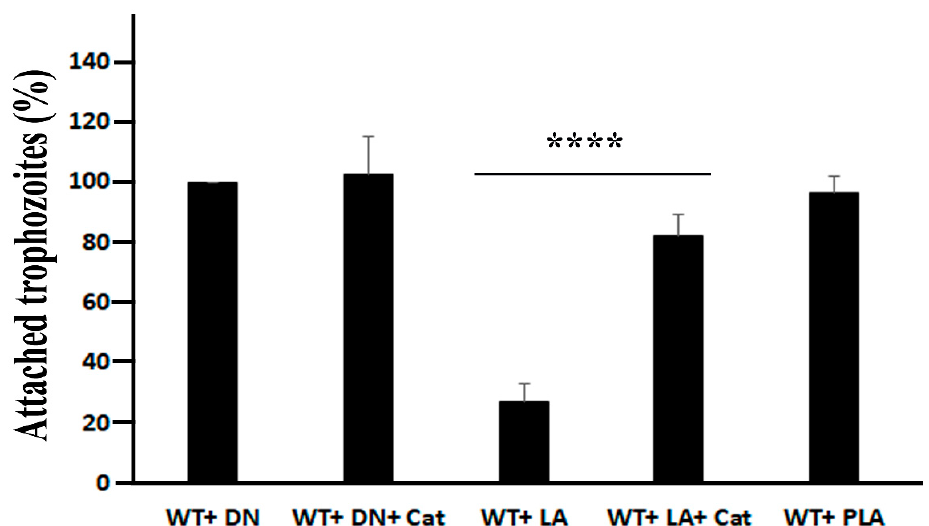
Figure 5. Binding activity assay of E. histolytica trophozoites. Note: E. histolytica trophozoites were incubated with live L. acidophilus (LA), with heat-killed L. acidophilus (DN), with paraformaldehyde- fixed L. acidophilus (PLA), and with/without catalase (50 μ g/mL) for 1 h at 37 °C and then transferred to paraformaldehyde-fixed HeLa cell monolayers. Trophozoites attached to HeLa cells monolayers were counted. The number of trophozoites incubated with heat-killed L. acidophilus (WT + DN) that were bound to HeLa cells monolayer (around 75% of the original population) was obtained as 100%. The data represent two independent experiments performed in duplicate. **** p -value < 0.0001 by an unpaired Student’s t -test.